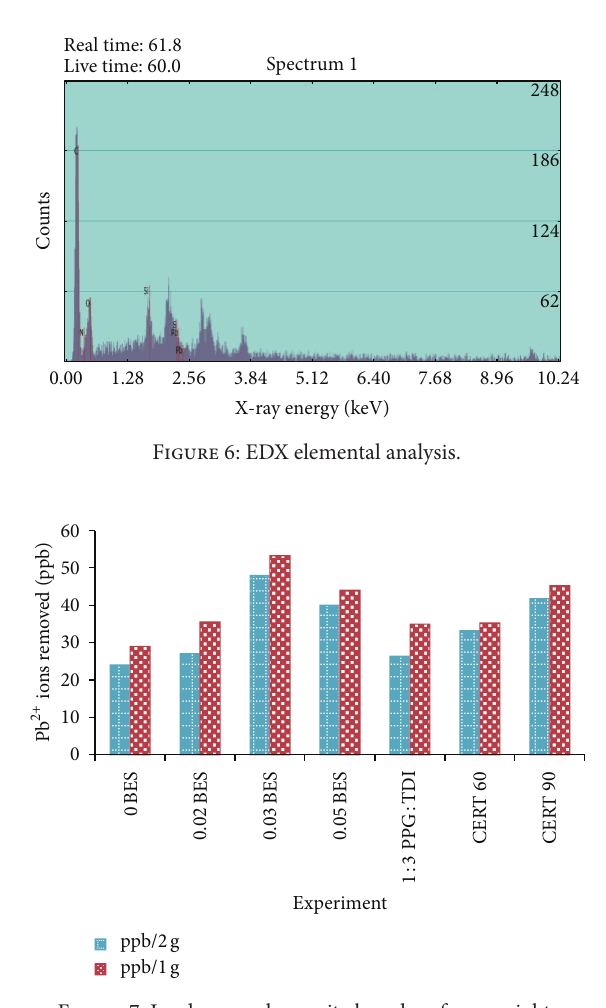
Figure 7: Lead removal capacity based on foam